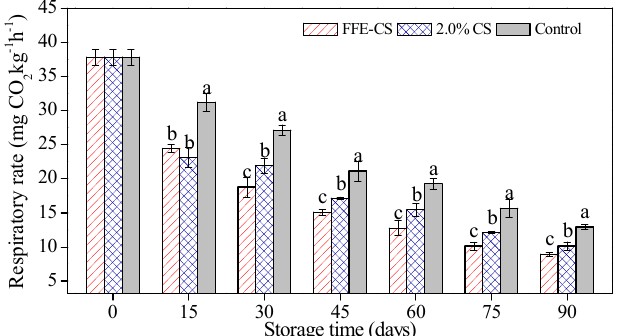
Figure 4. Effect of FFE–CS coating on respiration rate of Xinyu tangerines during cold storage for 90 days. Differences between treatments for each time were analyzed using Duncan’s multiple range test at P < 0.05.